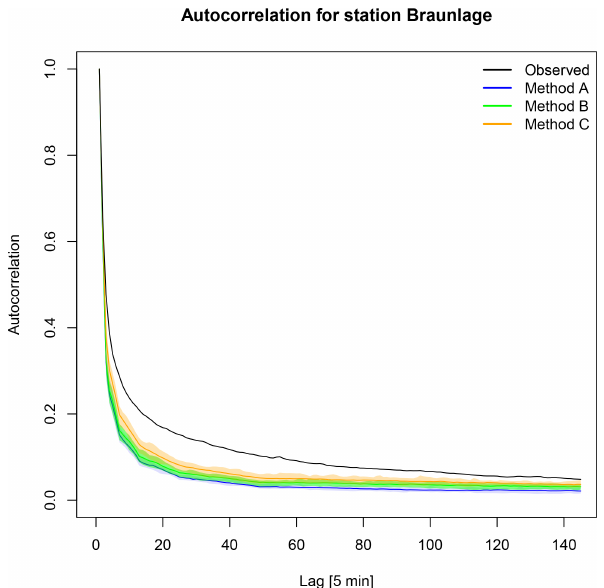
Figure 8. Autocorrelation of observed and disaggregated time se- ries using the standard approach for each method with no modifi- cation regarding too small rainfall intensities. The range for each method results from 30 realisations, and the solid line represents the